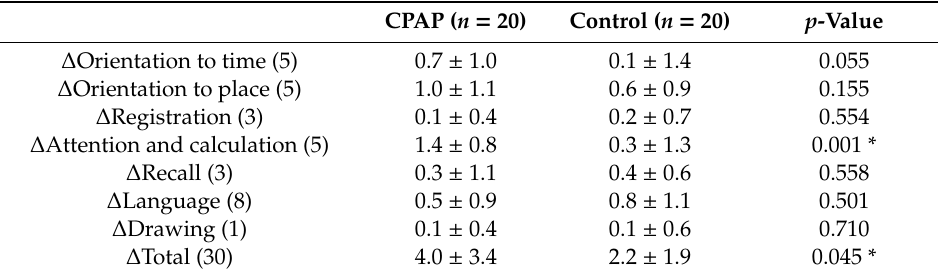
Table 3. Comparison of cognitive outcome between CPAP and control group.